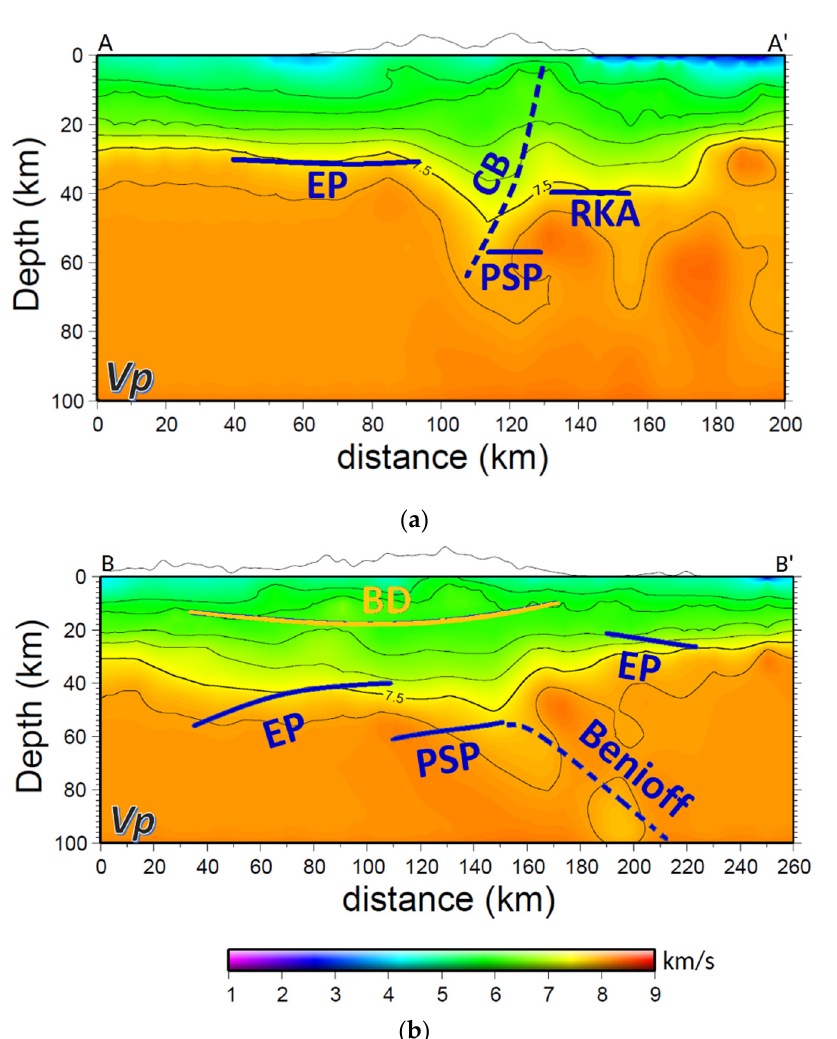
Figure 7. The tomographic P-wave velocity model built by Kuo-Chen et al. [13]. The interval of the contour lines is 0.5 km/s. The yellow and blue lines and blue dashed lines are the interpretation lines copied from Figures 5 and 6. ( a ) A-A (cid:48) profile. ( b ) B-B (cid:48)